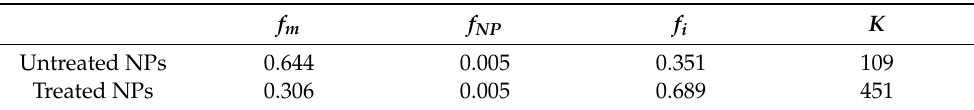
Table 2. The matrix ( f m ), NPs ( f NP ), and interphase ( f i ) volume fractions as well as the interaction parameter K for untreated and treated nanocomposites.